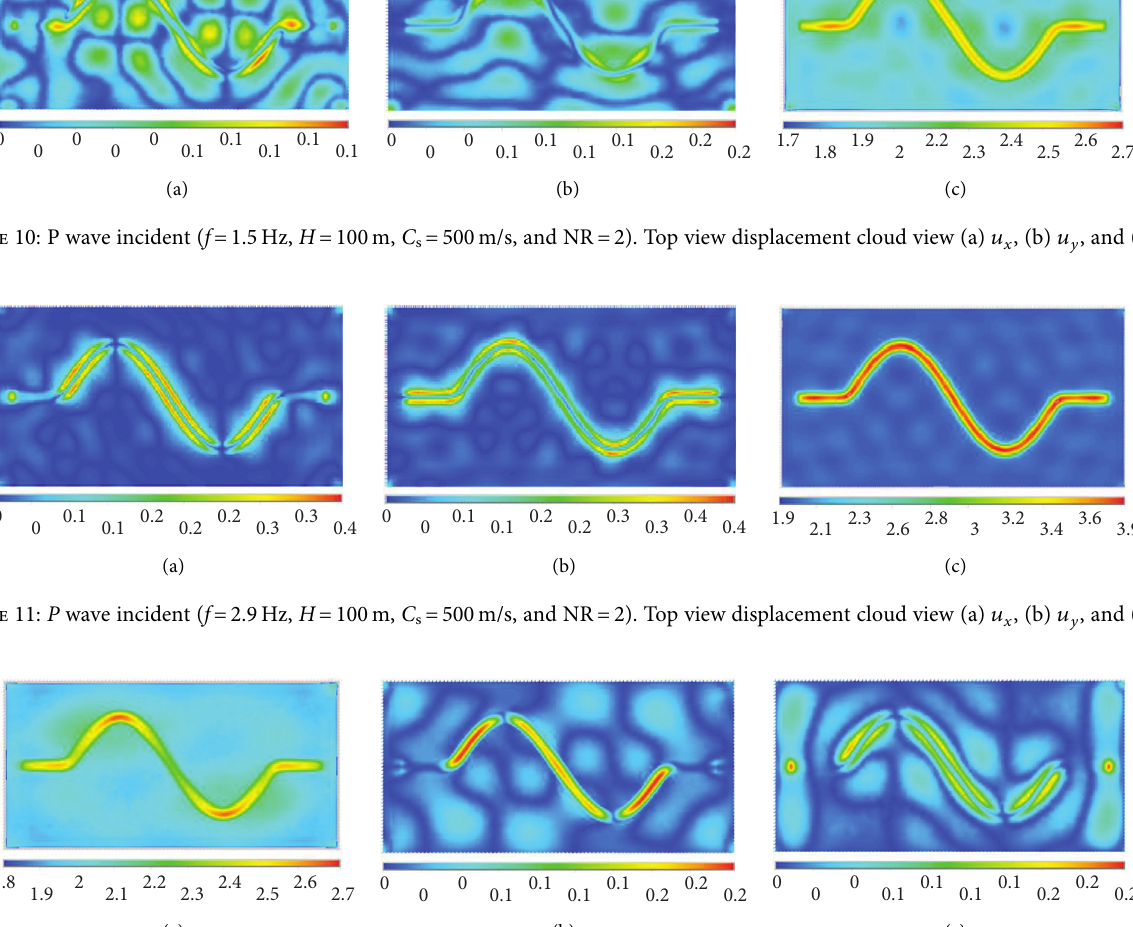
� 500 m/s, and NR � 2). Top view displacement cloud view (a) u s